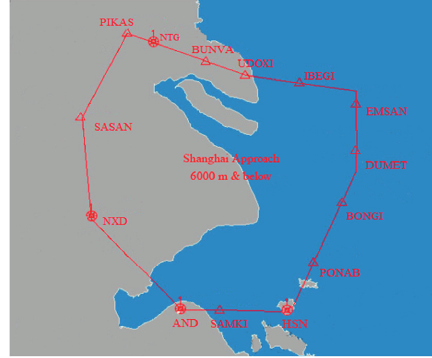
Figure 9: The border of Shanghai Approach.